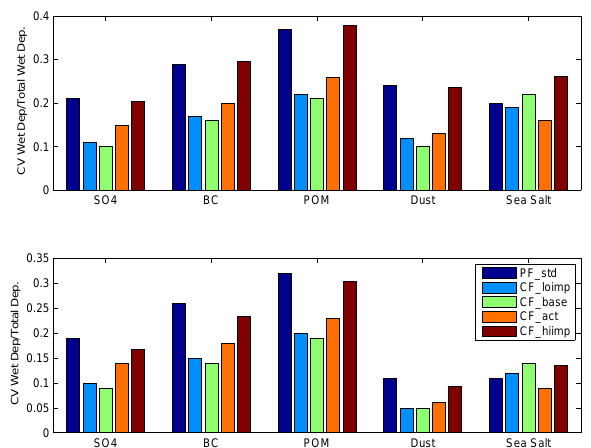
Fig. 1. The annual and global mean convective wet deposition rela- tive to the total (stratiform and convective) wet deposition of aerosol mass (top panel), and relative to the total deposition of aerosol mass (bottom panel) for each aerosol species of the ECHAM5-HAM model: sulfate (SO4), black carbon (BC), particulate organic matter (POM), dust and sea salt, and for each of the five simulations of this study. Simulations are described in Table